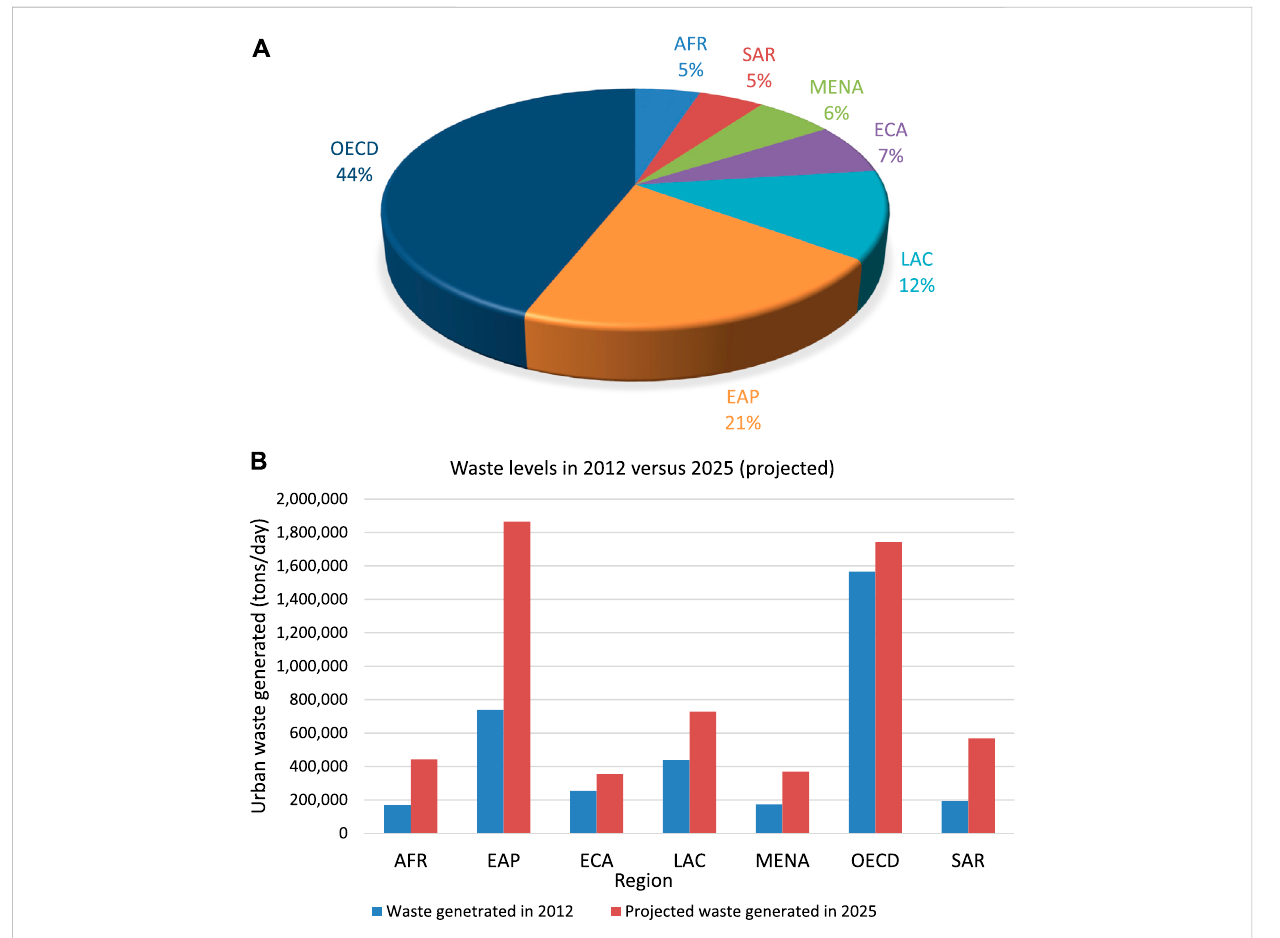
FIGURE 1 (A) Share of waste generation by region * [ based on the fi ndings of Hoornweg and Bhada-Tata, 2012. (B) Waste generation by region* for 2012 and 2025 (projected)[ based on the fi ndings of Hoornweg and Bhada-Tata, 2012.*(AFR: Africa; EAP: EastAsia & Paci fi c;ECA:Eastern &Central Asia; LCA: Latin America & the Caribbean; MENA: Middle East & North Africa; OECD: Organization for Economic Cooperation & Development; SAR: South